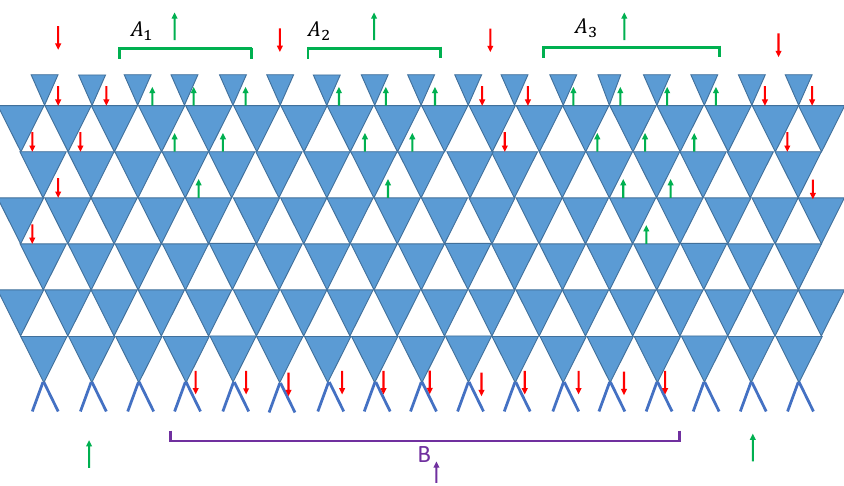
Figure 22 . We show the lattice for the partition function corresponding to (A.4) for a case with A consisting of three intervals and t = 7 . The boundary conditions, and the spins in the bulk fixed by the boundary conditions through the rules in figure 21 and figure 19, are shown explicitly. The remaining spins can be either up or down, but in the large q limit we need to consider a relatively small number of